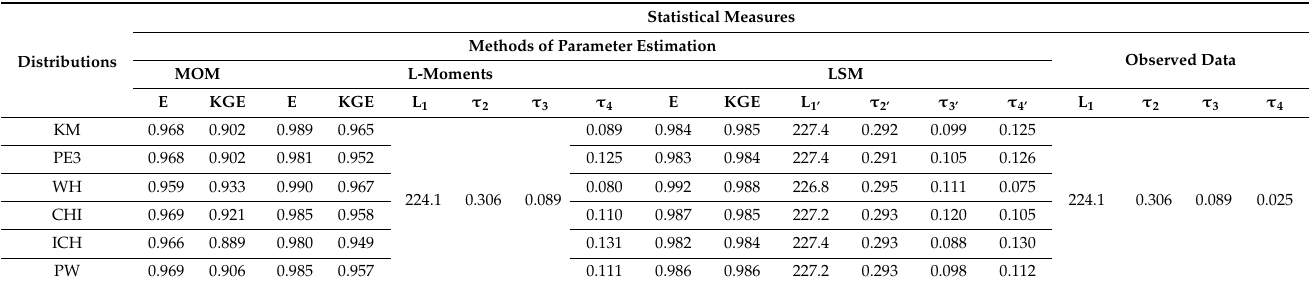
Table 9. Distributions performance